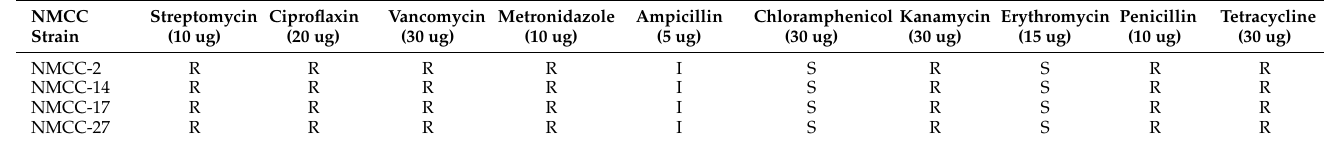
Table 4. Antibiotic resistance profiles of selected LAB strains.